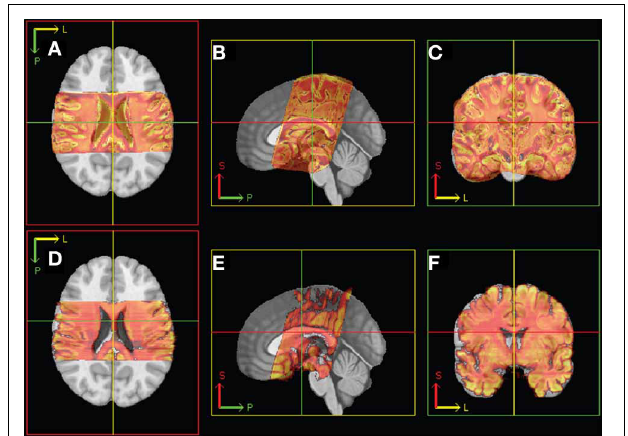
FIGURE 6 | Illustration of linear registration from MR (top: A–C) and histology (bottom: D–F) 3D volume to T1 template. Axial (left), sagittal (middle), and coronal (right) views. P, posterior; S, superior; L, left.